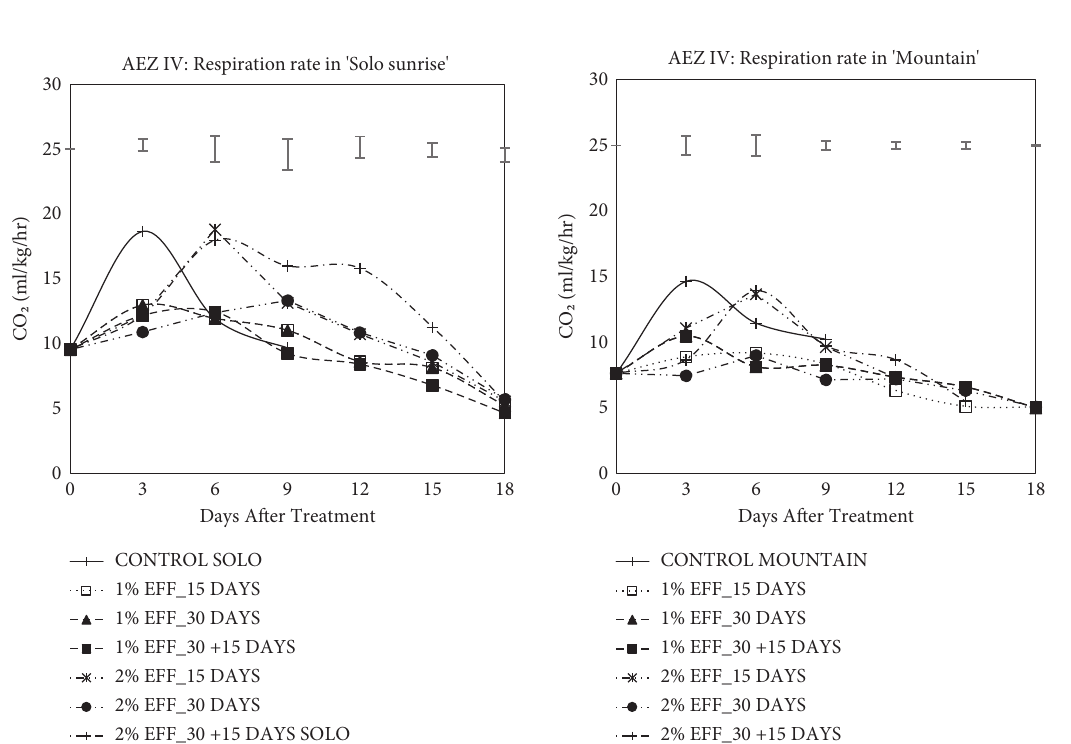
Figure 5: The rate of respiration/Co ₂ evolved from ripening papaya fruits treated with Hexanal spray from Machakos and Meru counties. Top bars represent LSD at